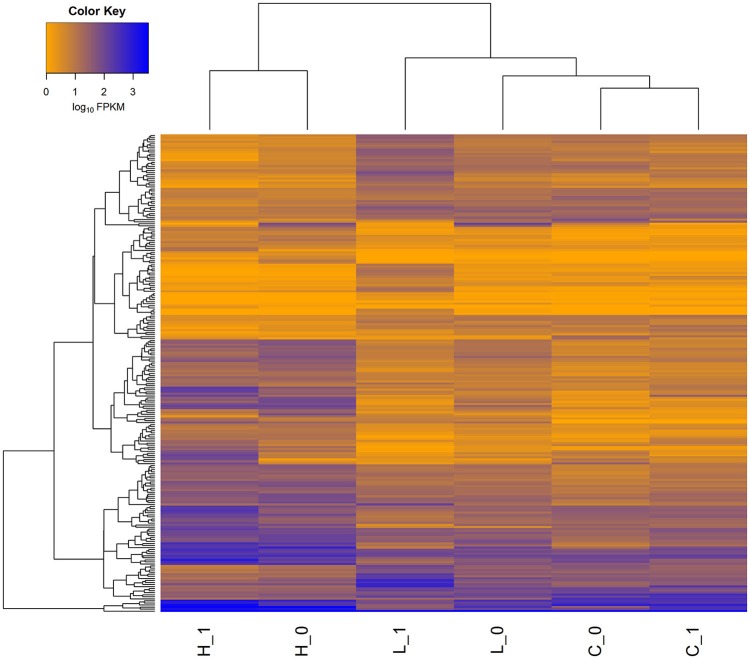
Heat-map of gene expression for all the differentially expressed genes (DEGs) in three comparisons. A total of 315 genes was differentially expressed (FDR < 0.05) in three comparisons (i.e., High vs. Control, Low vs. Control, and High vs. Low). H_0 and H_1 represent the two biological replicates in High group, L_0 and L_1 represent the two biological replicates in Low group, while C_0 and C_1 represent the two biological replicates in Control group. The FPKM values of genes (rows) are ordered using hierarchical clustering, and the samples are grouped according to the similarity of expression profiles of genes.